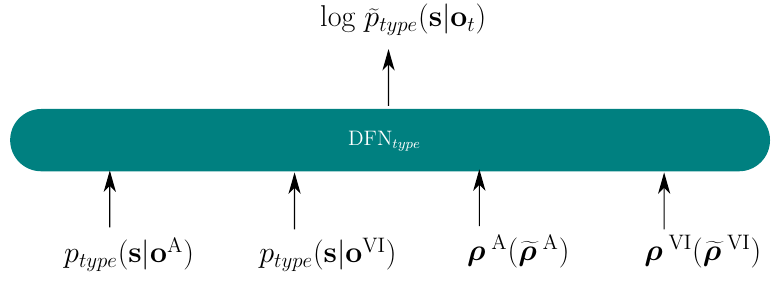
Figure 5. DFN fusion topology for E2E model, type ∈ s 2 s , ctc